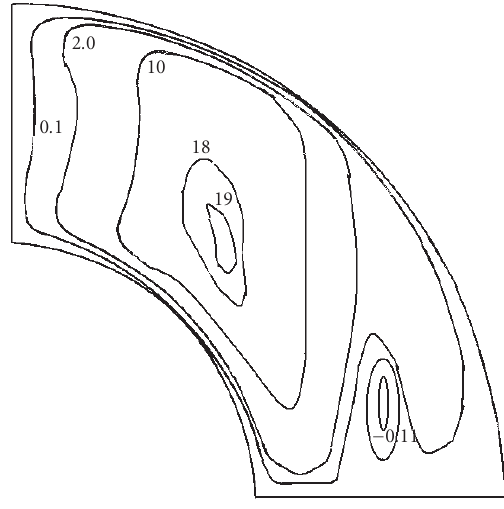
Figure 4.2. Level ψ curves multiplied by 10 4 for Re =